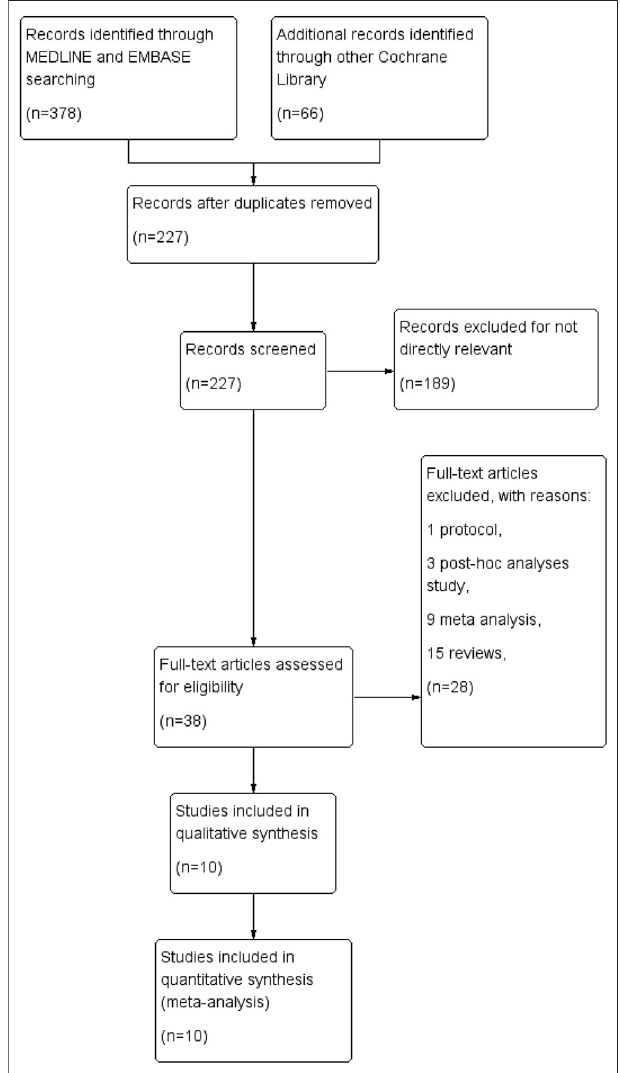
FIGURE 2 | PRISMA fl owchart of the study search, selection, and inclusion